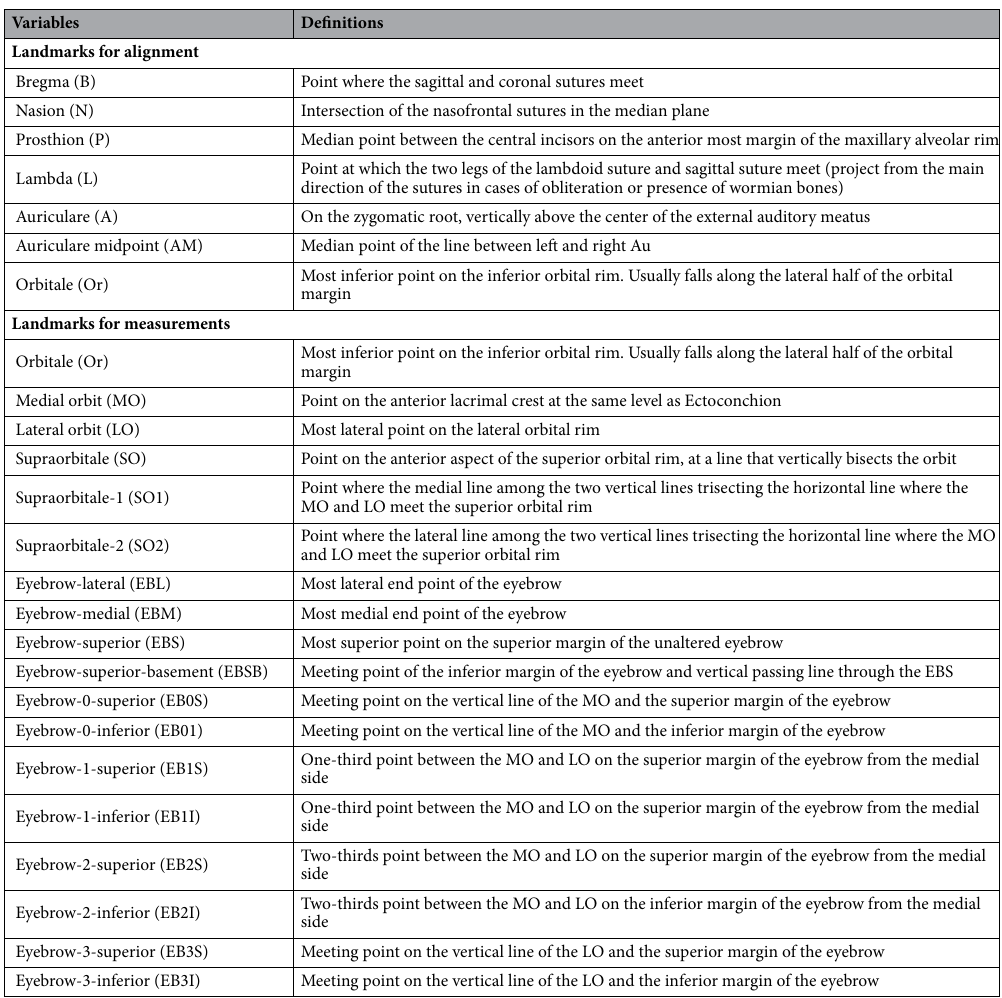
Table 4. Variables and definitions of anatomical landmarks for the eyebrow and